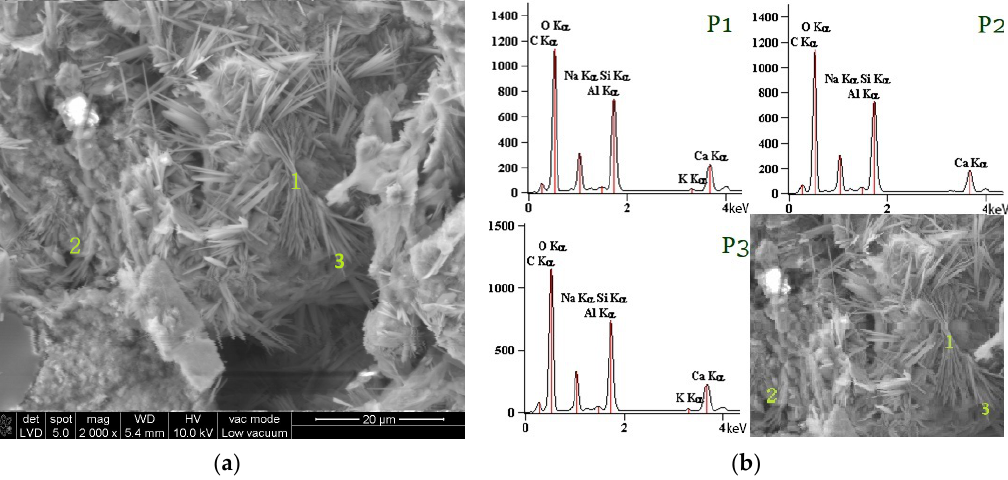
Figure 23. Microstructure of silicate brick modified by 90% glass sand 36 months after the laboratory production; ( a ) SEM image of brick modified by 90% GS, 20 μ m magnification; ( b ) EDS spectrum of brick modified by 90% GS at points 1, 2, and 3. Table 2. EDS analysis results for a brick modified by 90% GS (after 36 months).